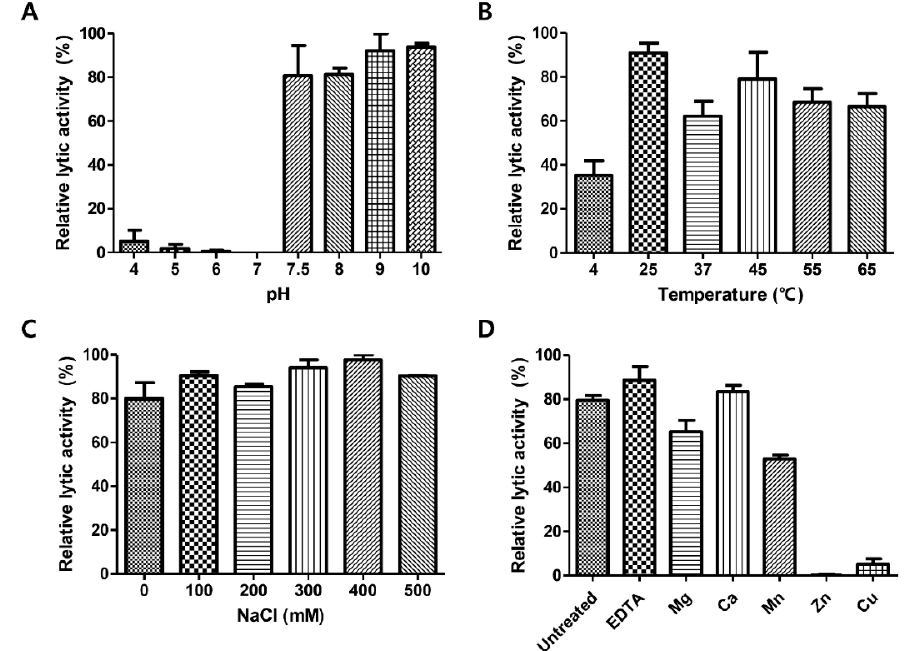
Figure 3. Effects of pH, temperature, NaCl and metal ions on the lytic activity of LysCPS2. Effects of ( A ) pH, ( B ) temperatures, ( C ) NaCl, and ( D ) metal ions on the lytic activity of LysCPS2 against C. perfringens ATCC 13124 cells. Each column represents the mean of triplicate experiments, and error bars indicate the standard deviation.